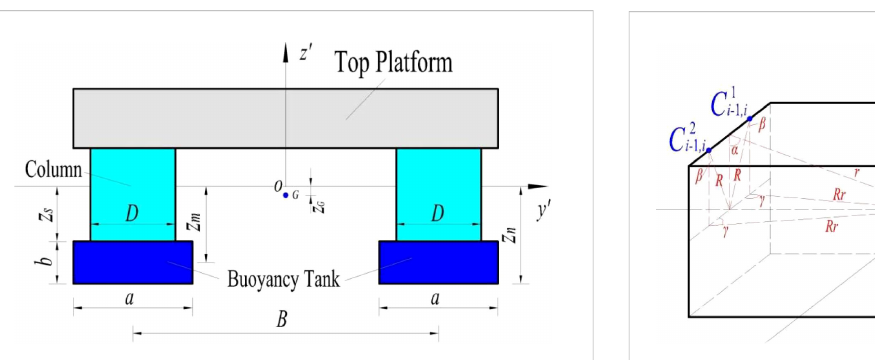
FIGURE 8 Simpli fi ed geometric model for a single CP-VLFS module and